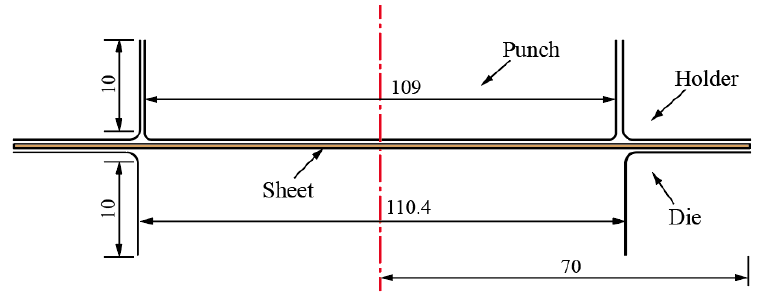
Table 2. Hot-stamping process parameters of AZ31 magnesium alloy sheet.